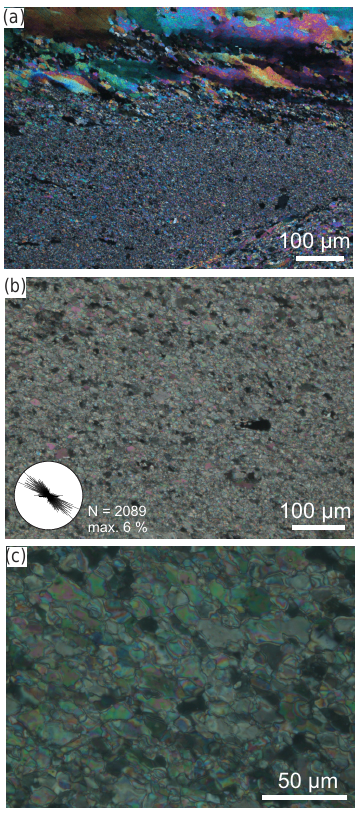
Figure 2. Optical micrographs of calcite marble (crossed polar- izers). (a) Transition between host rock and fine-grained ultra- mylonite. Note the extreme grain size reduction. (b) Fine almost equigranular ultramylonite. The inserted sketch represents a rose di- agram showing the 2-D orientation of the long axis of calcite grains. (c) Close-up of fine-grained ultramylonite. Note that grain bound- aries of coarser grains are strongly curved compared to smaller